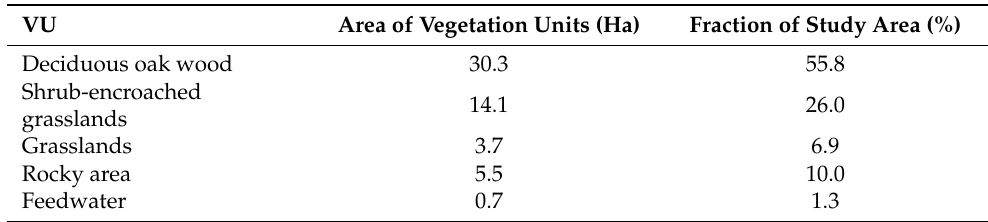
Table 2. Area and frequency of occurrence (% of the experimental area) of the three vegetation units (VUs), rocky areas and feedwater.